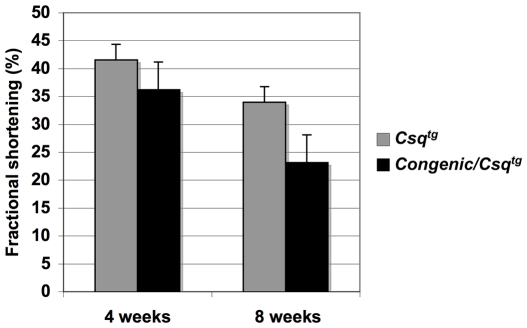
One copy of the AKR allele at Hrtfm2 leads to an acceleration of cardiomyopathy in the Csqtg transgenic model of cardiomyopathy.Echocardiographic analysis showed decreased fractional shortening in Csqtg transgenic mice on the congenic background (DBA. AKR-Hrtfm2) at 4 and 8 weeks of age, compared to their littermates with DBA Hrtfm2 alleles (p = 0.263 and 0.016). From 4 to 8 weeks, the fractional shortening was decreased 36% in Csqtg/Congenic mice (p = 0.0004), and 18% in Csqtg/DBA mice (p = 0.186). The number of animals in each group was as follows: Csqtg/DBA, 4 weeks, n = 7; 8 weeks, n = 7; Csqtg/Congenic, 4 weeks, n = 9; 8 weeks, n = 6. Data is represented by mean±SEM.